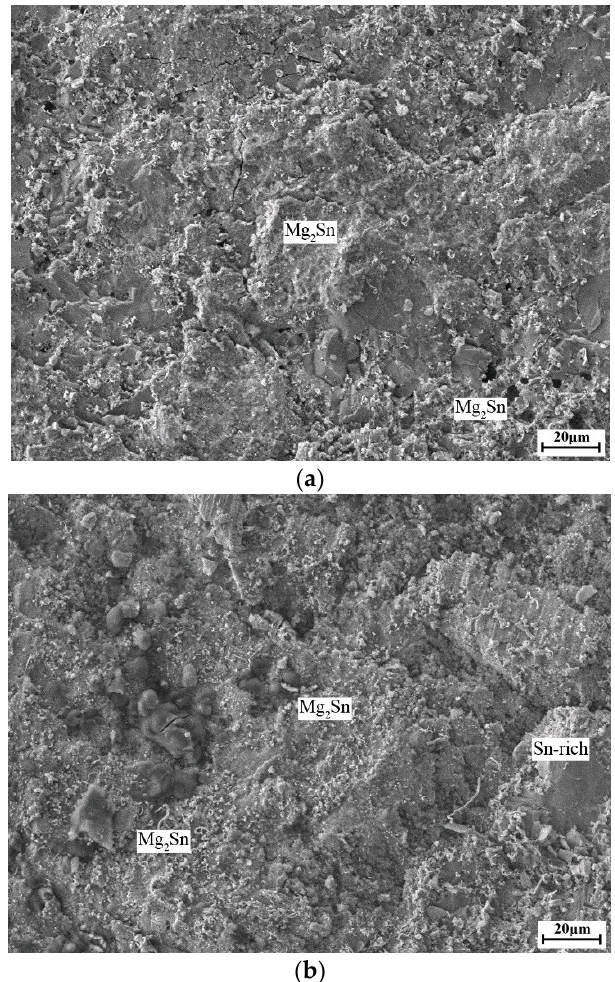
Figure 7. Fractography of the AZ31 magnesium alloy/6061 aluminum alloy joint bonded with the Sn-30Zn-0.1RE solder. ( a ) 6061 aluminum alloy side; ( b ) AZ31 magnesium alloy side. The shear strengths of the AZ31 magnesium alloy/6061 aluminum alloy joints soldered with Sn-xZn-0.1RE (x = 5, 10, 20, and 30) filler metals after aging at 150 °C for various times are presented